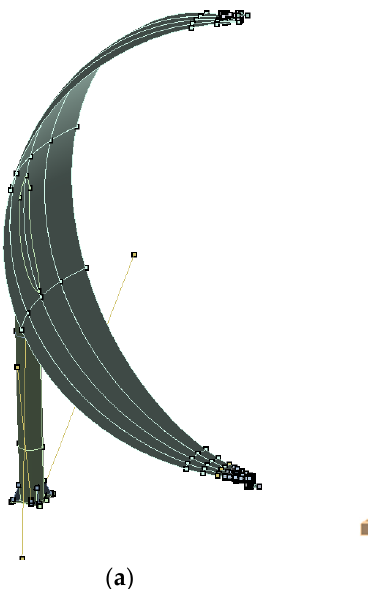
Figure 9. Geometric model of spherical tanks used in the stress analysis ( a ) solid surface model— general view ( b ) area detailed by means of a volumetric model.